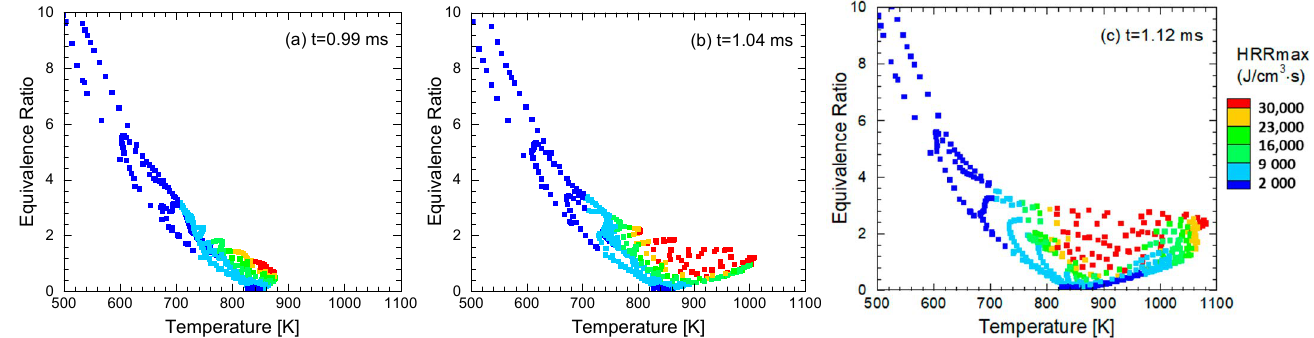
Figure 9. Φ -T diagram in CVB with a nozzle diameter of 0.15 mm (ambient gas initial temperature 850 K, ambient oxygen concentration 21%, gas density 14.8 kg/m 3 ).